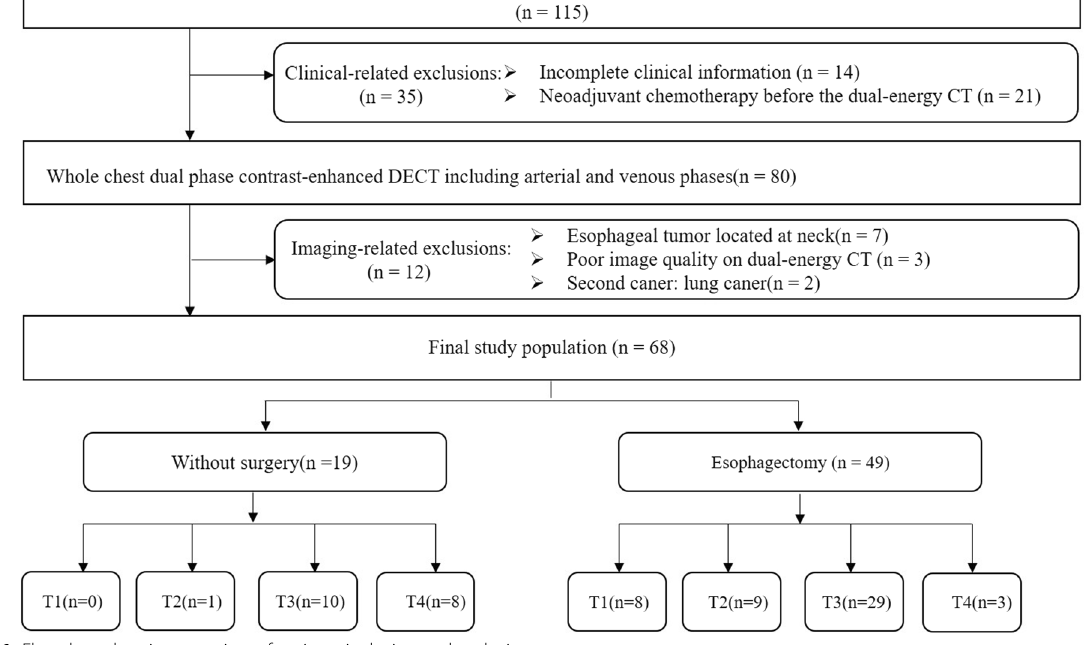
Fig. 1 Flowchart showing overview of patients inclusion and